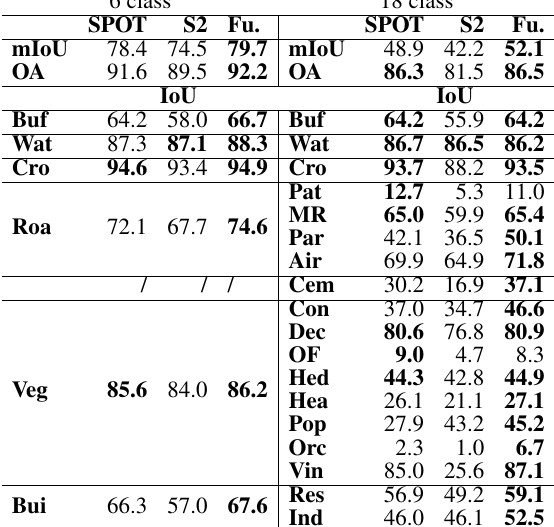
Table 2. Classification results (in %) for simple and complex legends from both sensors and for the proposed fusion CNN. ”Fu.” stands for